Question: Write a single sentence explaining what this figure depicts.
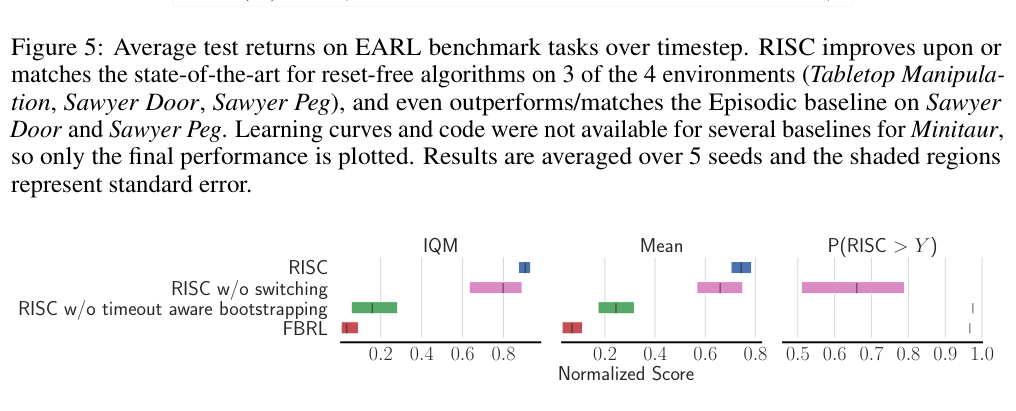
Answer: 95% confidence intervals for the interquartile mean (IQM), mean, and Probability of Improvement of RISC for ablations of RISC.